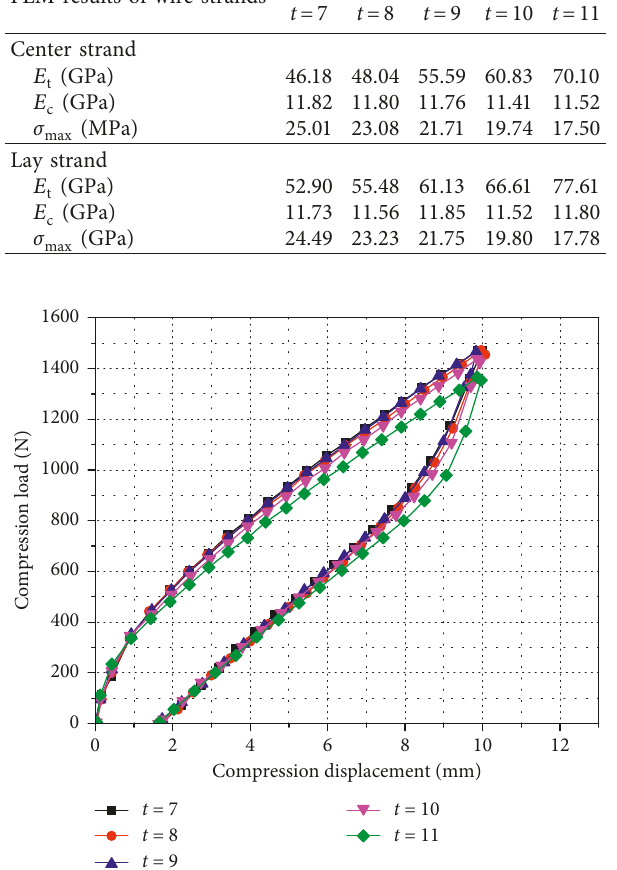
Table 5: The FEM results of single strands with different lay pitches. FEM results of wire strands